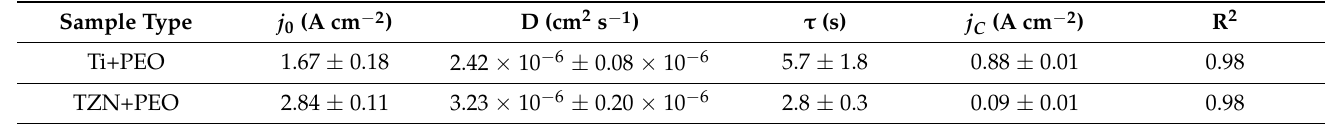
Figure 8. Experimental and modeled current density for PEO of the Ti ( a ) and Ti-Zr-Nb alloys ( b ). Table 6. Parameters of the kinetic model